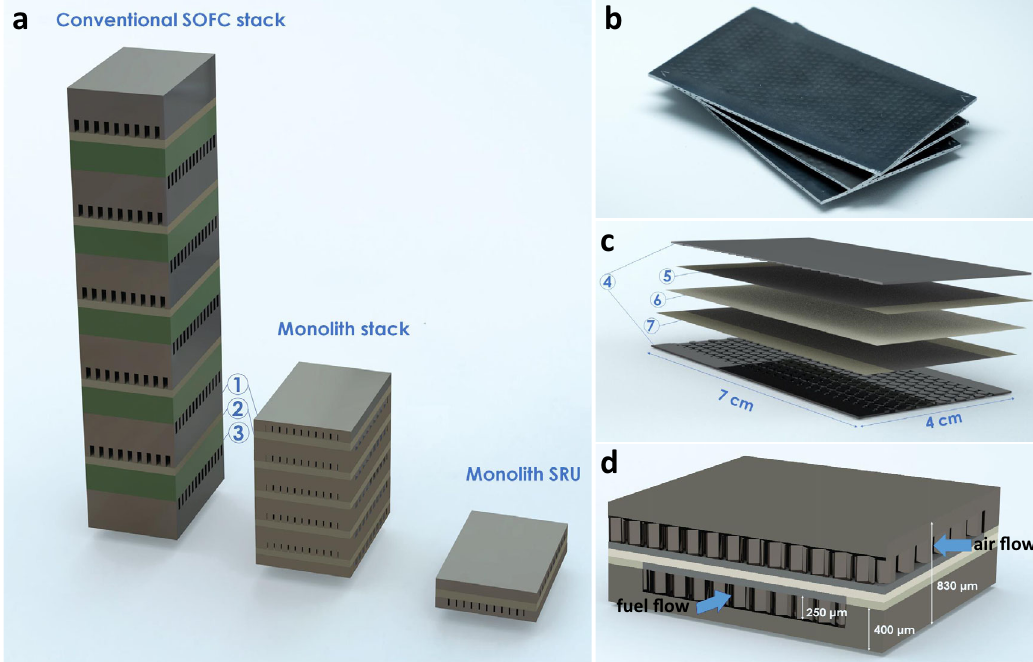
Fig. 1 Metal-based monolithic stack design. a Illustrations of conventional and monolith fuel cell stacks with fi ve repeat units and a single repeating unit (SRU) monolith stack. The numbers 1, 2, and 3 correspond to the interconnects, fuel cells (electrolyte and electrodes), and cell supports, respectively. b Photograph of three modules of SRU monolith. c Illustration of an exploded view of a SRU monolith. The numbers 4, 5, 6, and 7 correspond to interconnects and gas distribution channels (400 µ m thick including 250 µ m high gas channels), electrodes (10 µ m), electrolyte (10 µ m), and sealing (10 µ m), respectively. d Enlarged cross-sectional view of a SRU monolith (for clarity, the scale of the layers thickness is not